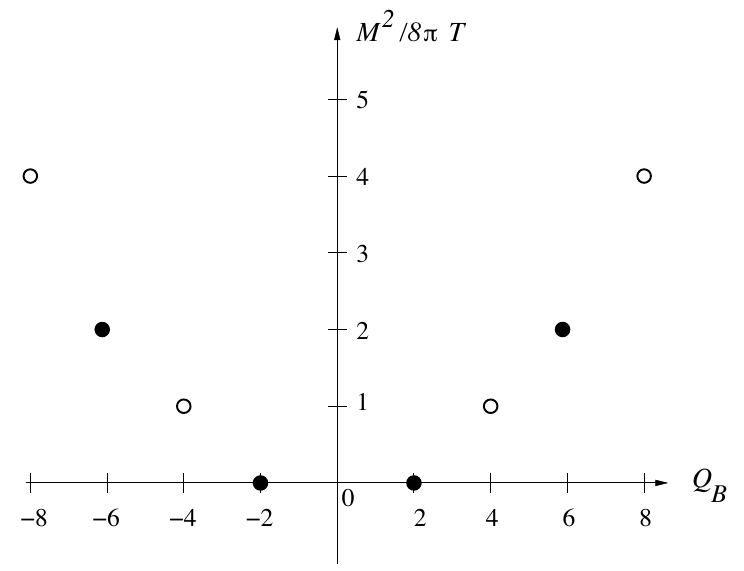
Figure 2 . Spectrum of spin-0 and spin-2 states as a function of the baryonic charge. Closed and open circles denote spin-0 and spin-2 states,